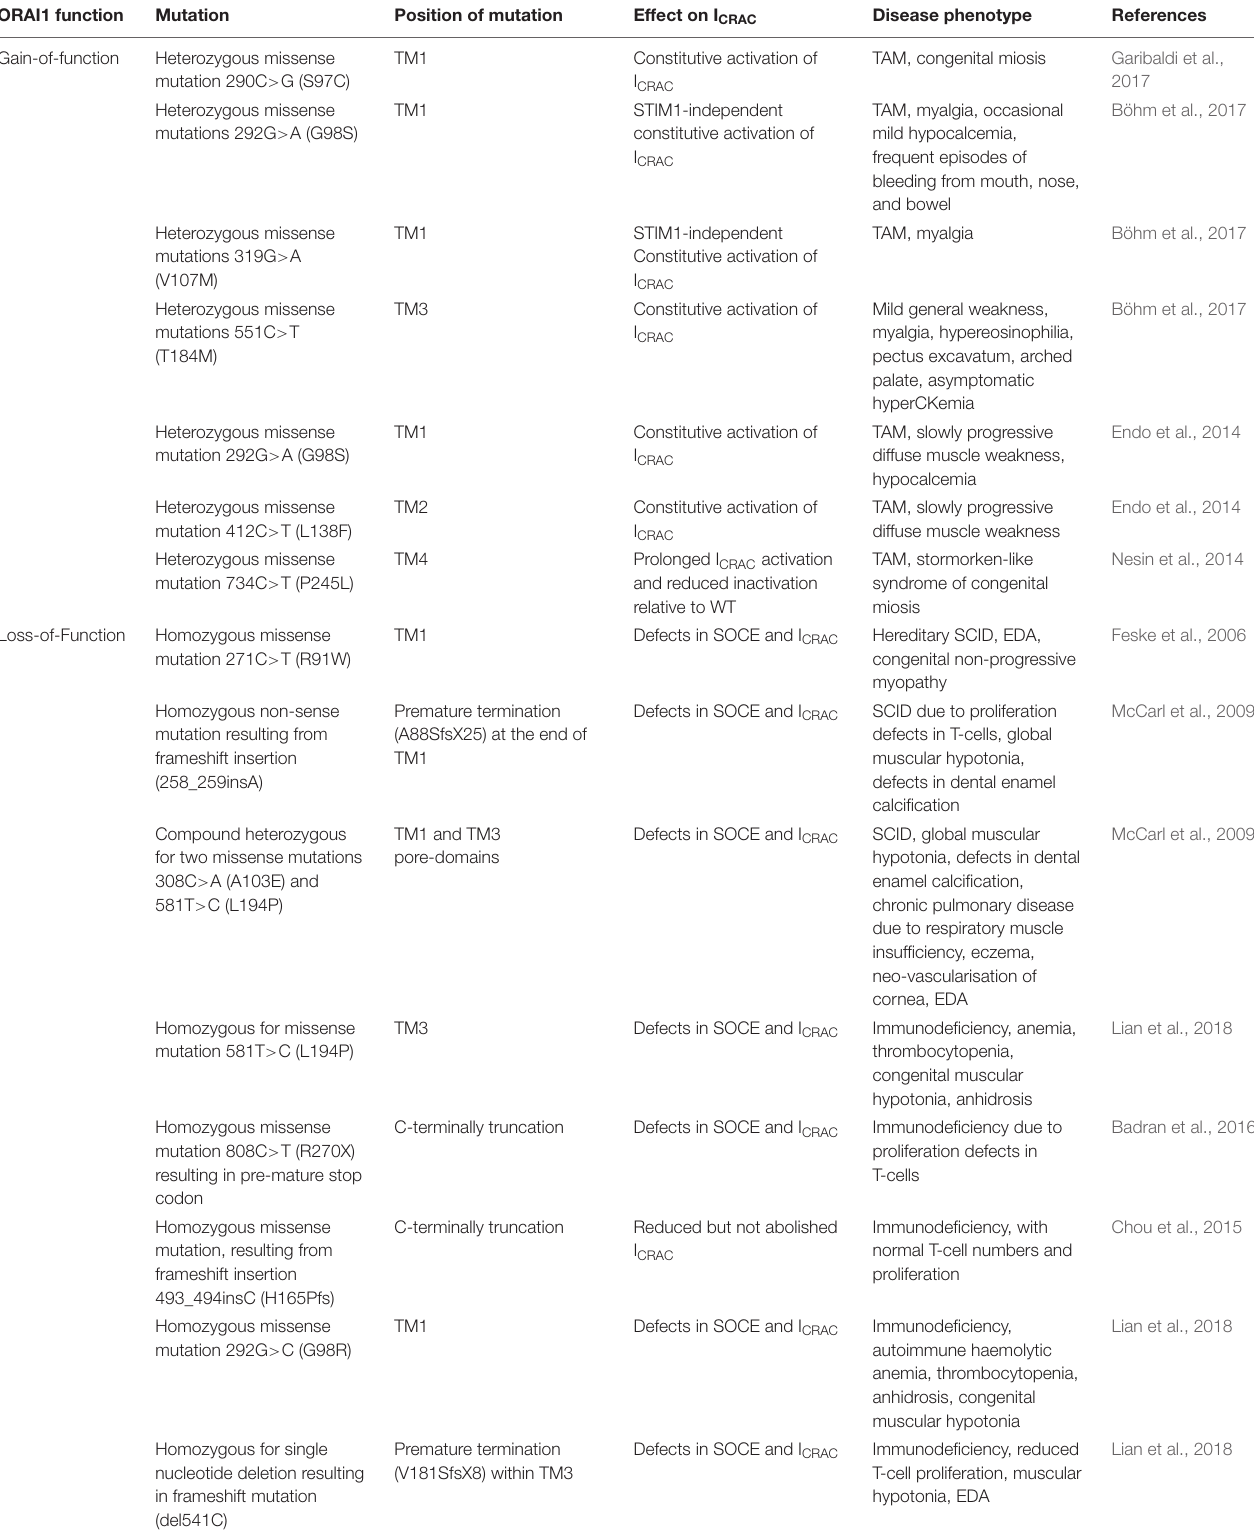
TABLE 1 | Human ORAI1 (NM_032790.3) mutations and the associated disorders. ORAI1